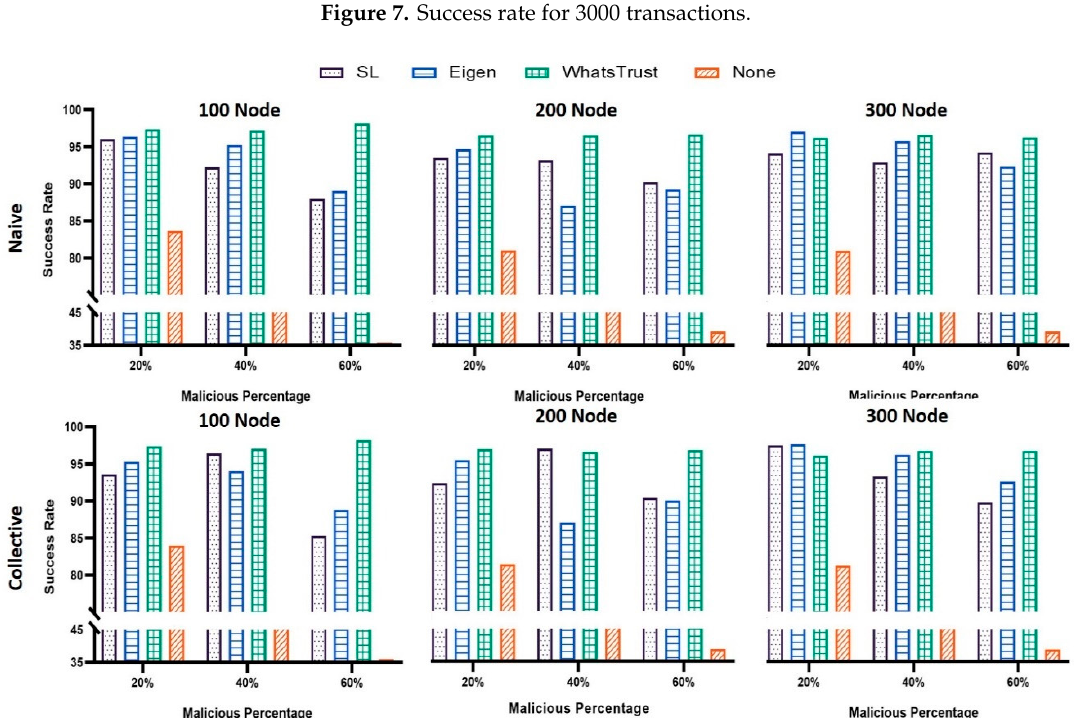
Electronics 2020 , 9 , x FOR PEER REVIEW Figure 7. Success rate for 3000 transactions. Figure 7. Success rate for 3000 transactions.